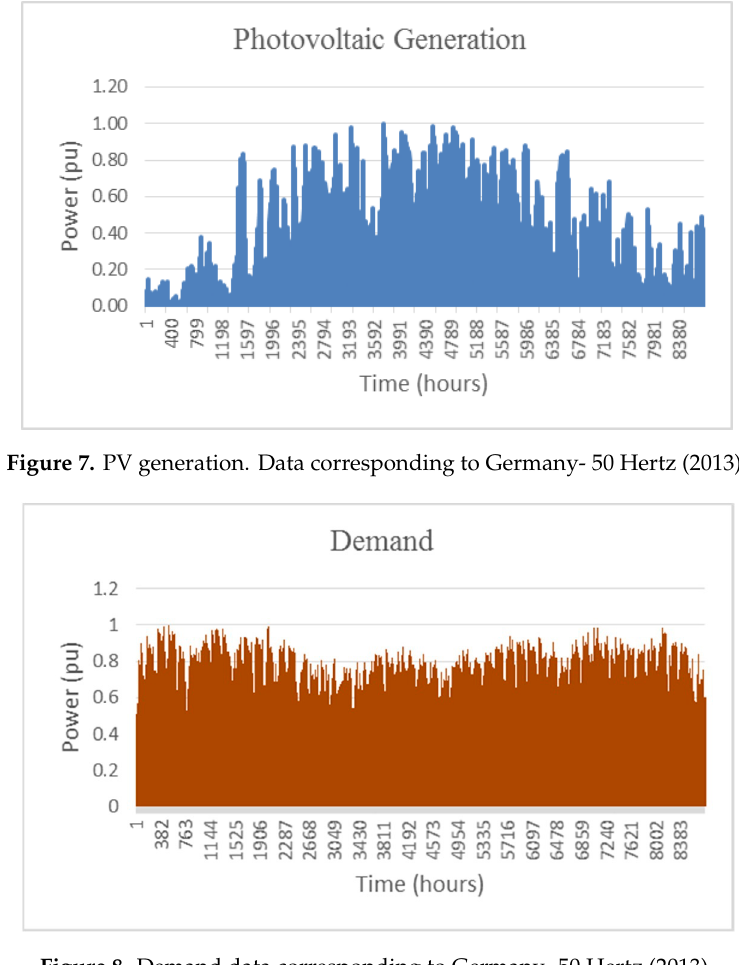
Figure 8. Demand data corresponding to Germany- 50 Hertz (2013) .